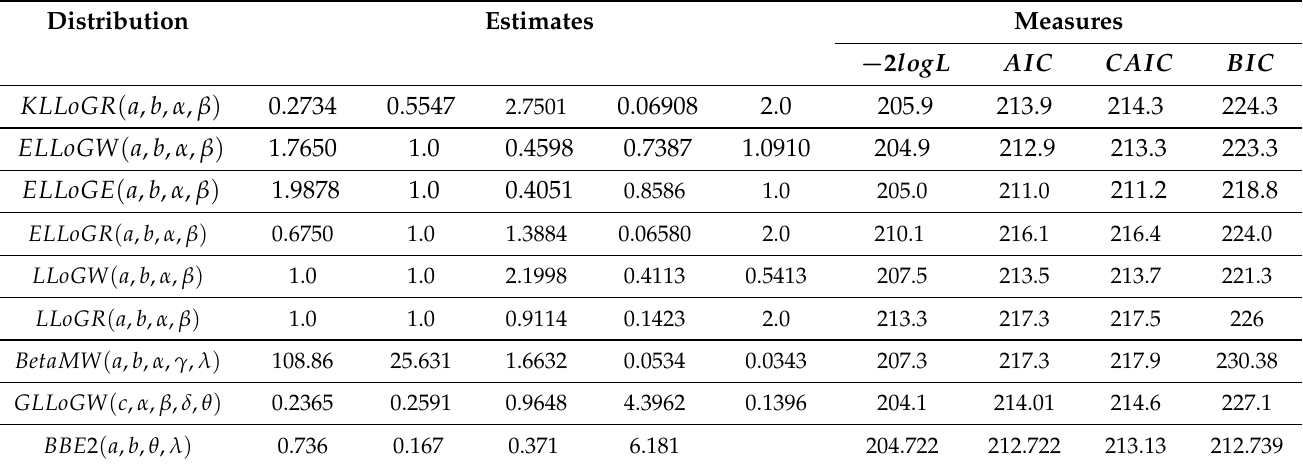
Figure 4. Plots of the estimated survival and QQ plot for the BBE 2 model. Table 15. Summary of fitted distributions corresponding to Stress-Rupture life of Kevlar 49/Epoxy Strands